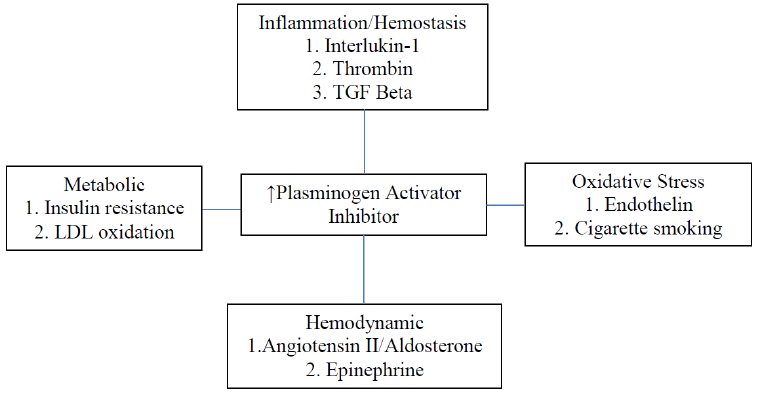
Figure 2. Increased Expression of Plasminogen Activator Inhibitor.